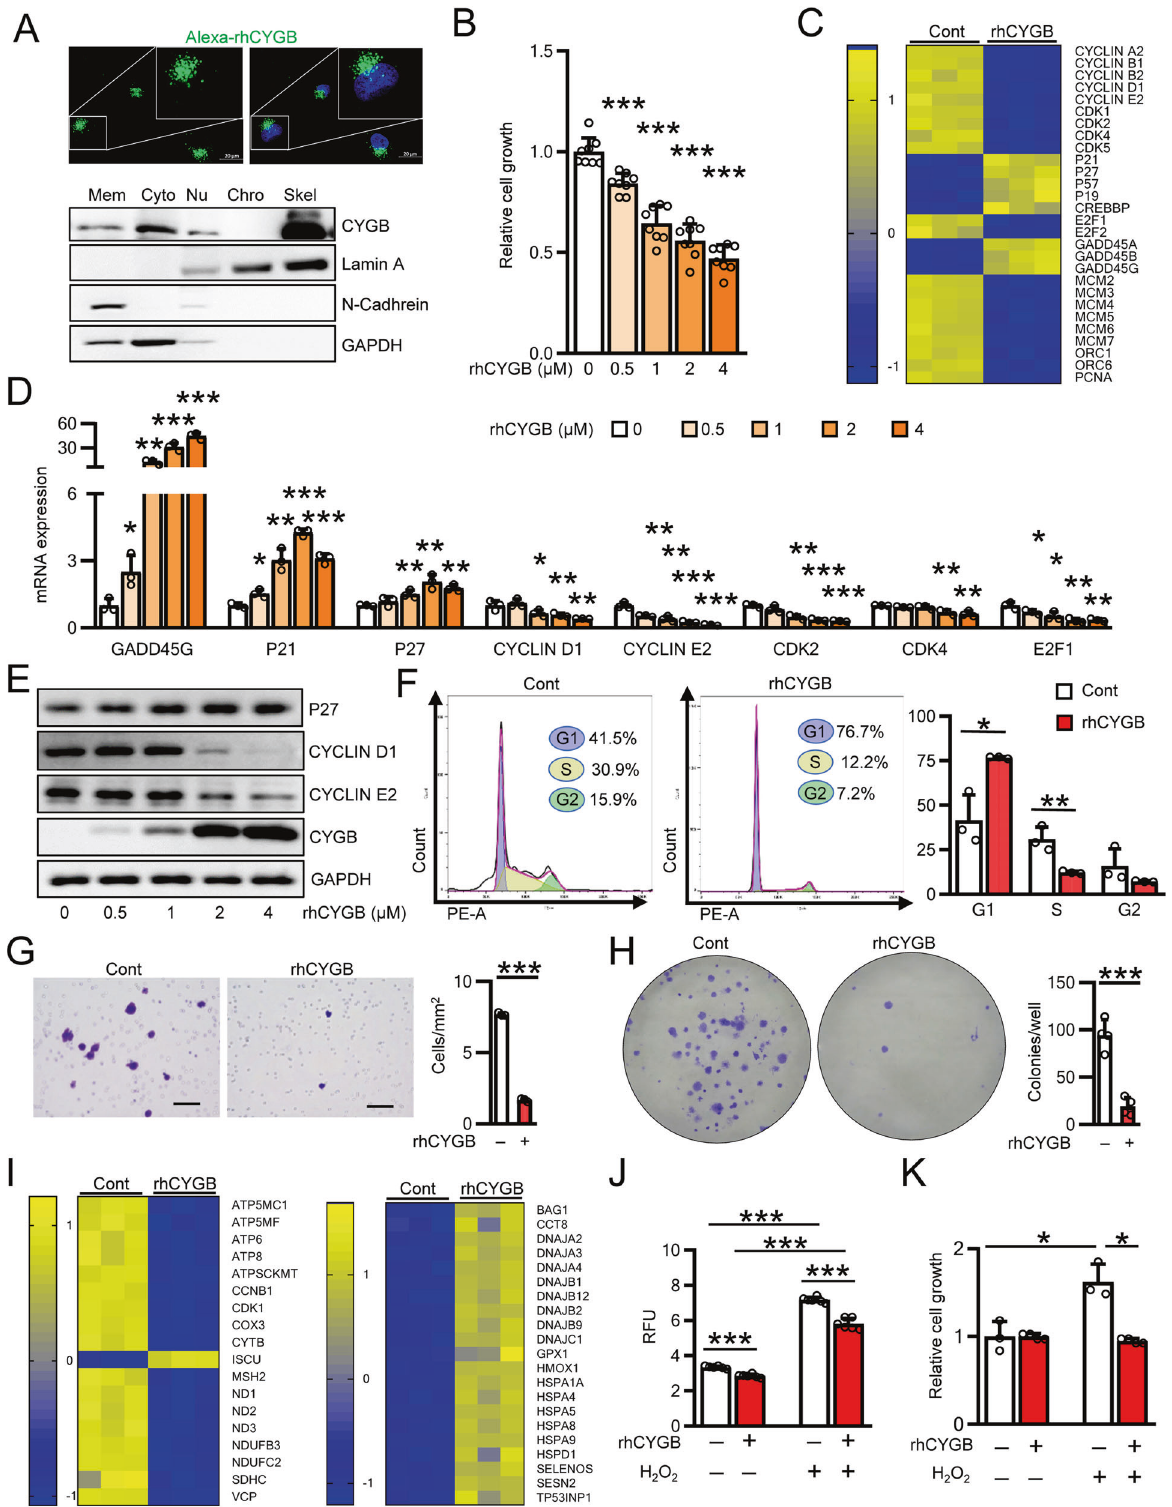
TG mice are resistant to oxidative stress and fi brosis development in multiple models of liver fi brosis induced by thioacetamide, choline-de fi cient diet, or bile duct ligation [37, 48, 71]. By contrast, primary cultured HSCs isolated from CYGB-de fi cient mice show robust ROS accumulation, similar to those isolated from WT